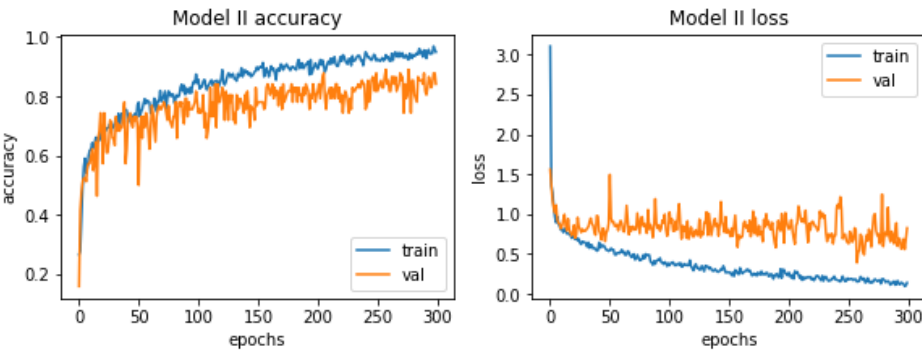
Figure 13. Accuracy and losses when teaching the second model.